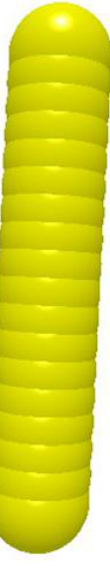
Figure 7. Tea particle simulation model. Table 2. Parameters used in simulation setting.